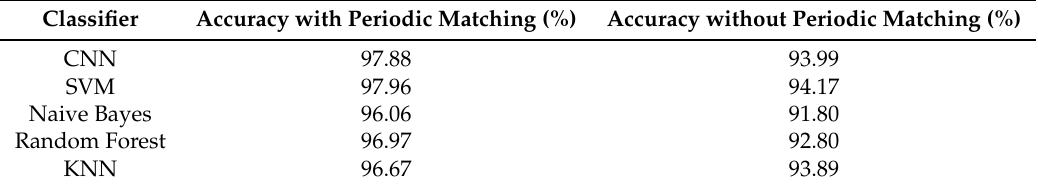
Table 6. Accuracy comparison of different classifiers with and without periodic